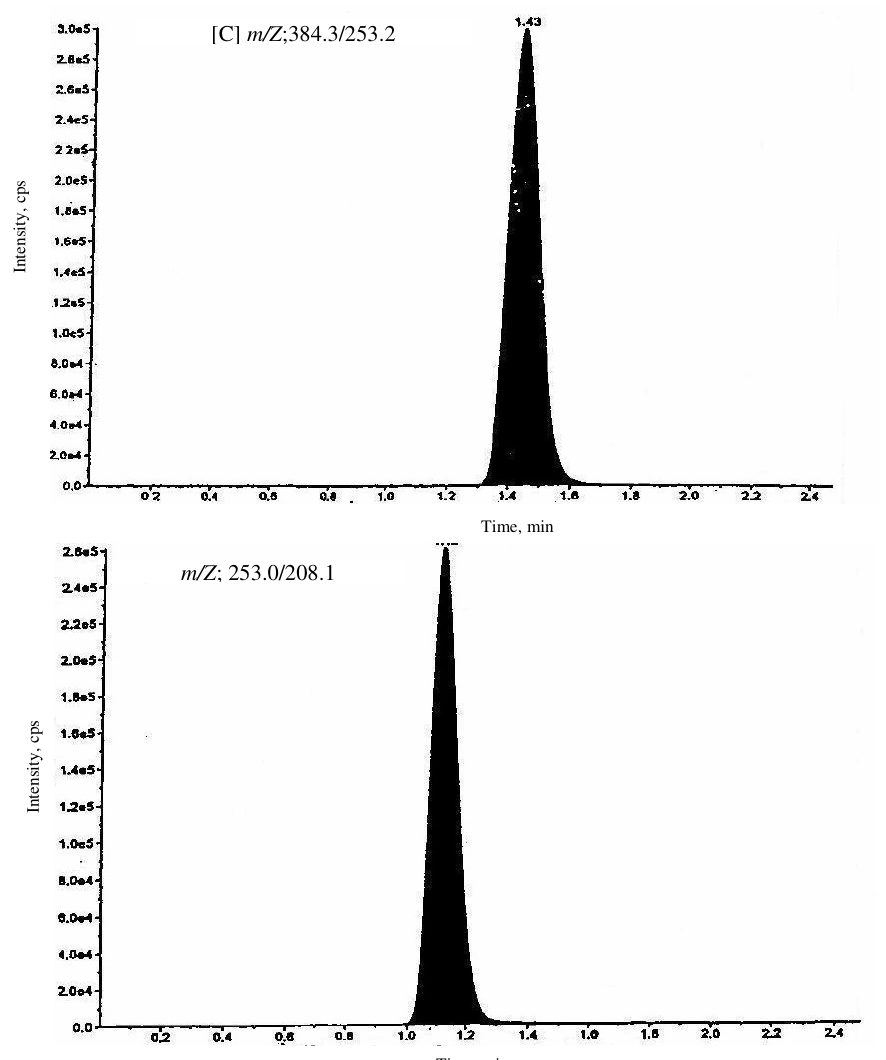
Figure 3. Typical MRM chromatograms of QUE (left panel) and IS (right panel) in (A) human blank plasma (B) human plasma spiked with IS (C) LLOQ sample along with